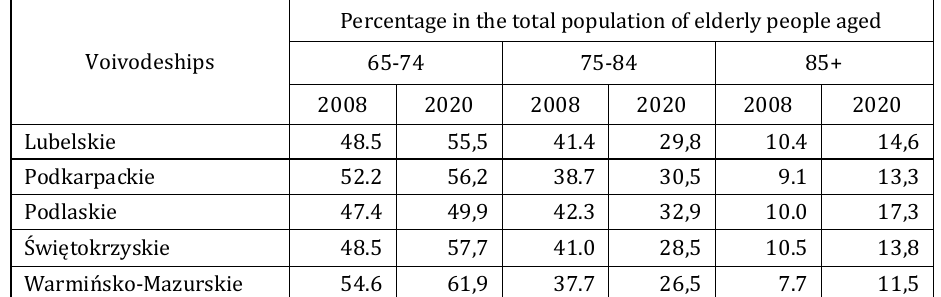
Table 5. Characteristics of the population aged 65+ in rural areas of Eastern Poland between 2008 and 2020 (Source: calculations of the authors based on data from the Local Data Bank of Statistics